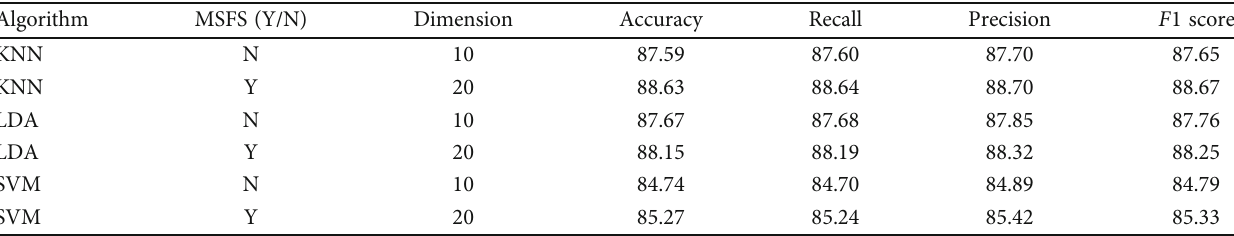
Table 5: The accuracy, recall, and precision of 10-gesture recognition (%).